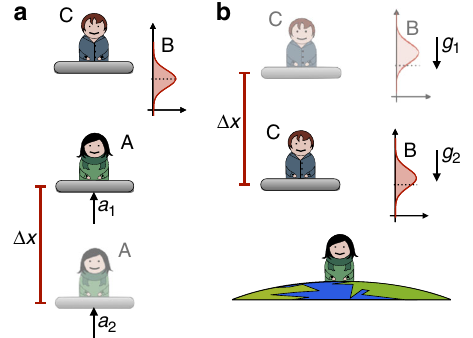
Fig. 7 Representation of the conditions under which particle A effectively moves in a superposition of accelerations. The state of particle A and the piecewise linear potential V ð ^ x are represented for the initial time 0 and A Þ from for the time t in two different yellow planes. At the initial time, in the A Þ background, the state is chosen to be a superposition of two coherent (Gaussian) states localised around x 1 , with width 2 σ 1 , and x 2 , with width 2 σ 2 . The individual states are localised within the spatial intervals that correspond to constant but different potential gradients. Under time evolution, the point where each of the two localised states is centred moves by δ x i , i ¼ 1 ; 2, and the wave-packet spreads. For each of them, it is possible to identify a maximal time such that the individual localised states in the superposition still remain in the region where the gradient of the potential is constant. Up to this time A evolves in a superposition of